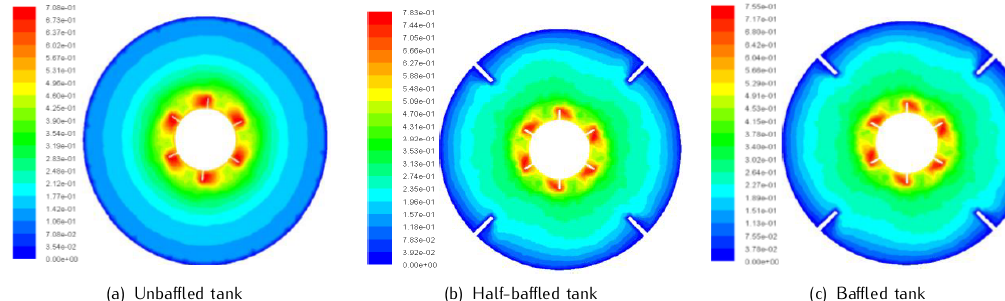
Figure 3. Distribution of the mean velocity in the r-